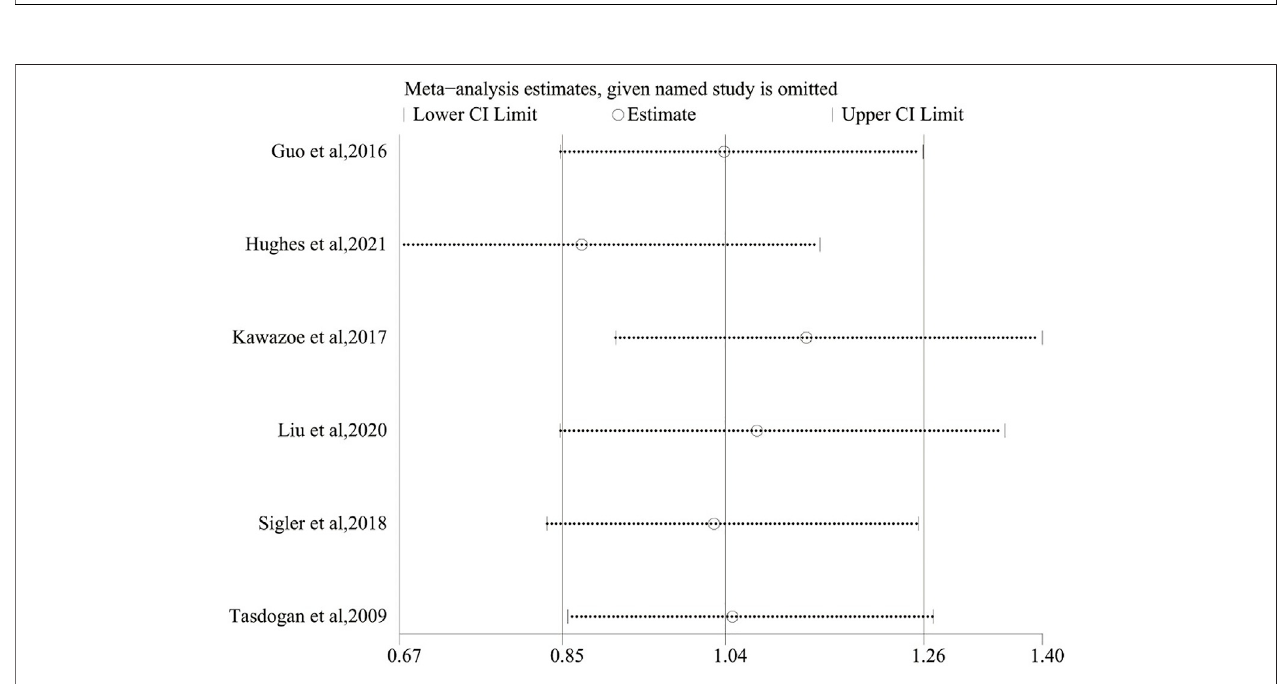
FIGURE 7 | Sensitivity analysis of 28/30-day mortality by